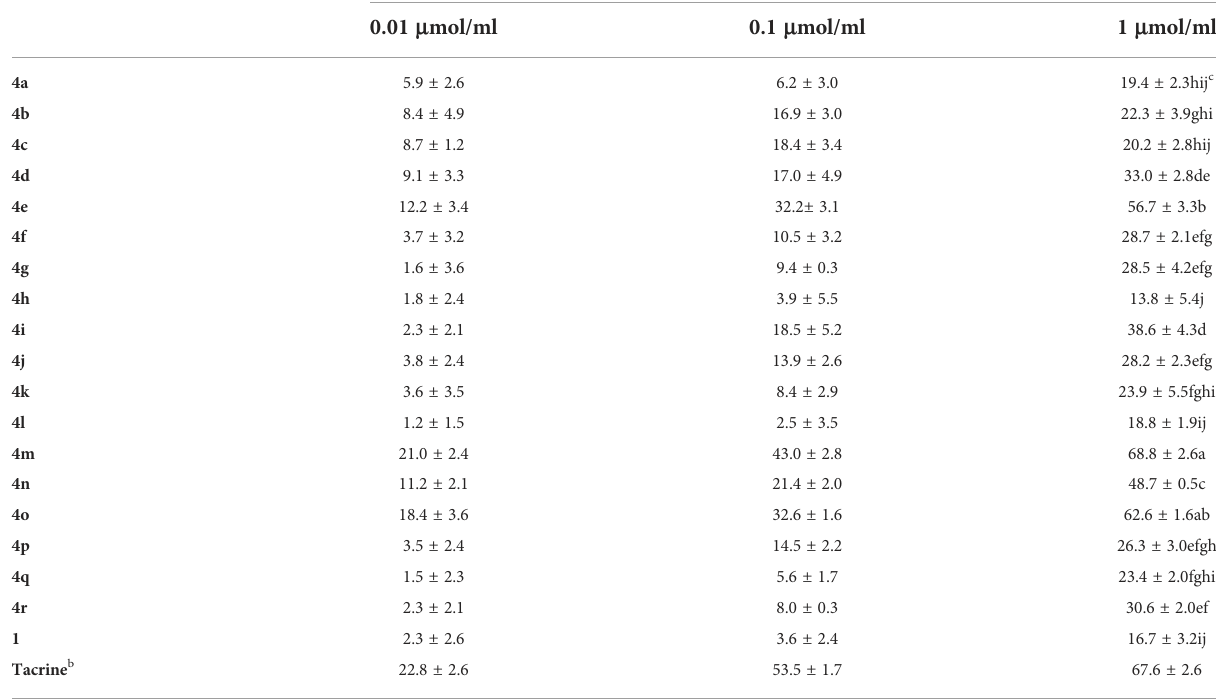
TABLE 1 The inhibitory activity of titled compounds ( 4a – 4r ) against AChE in vitro .